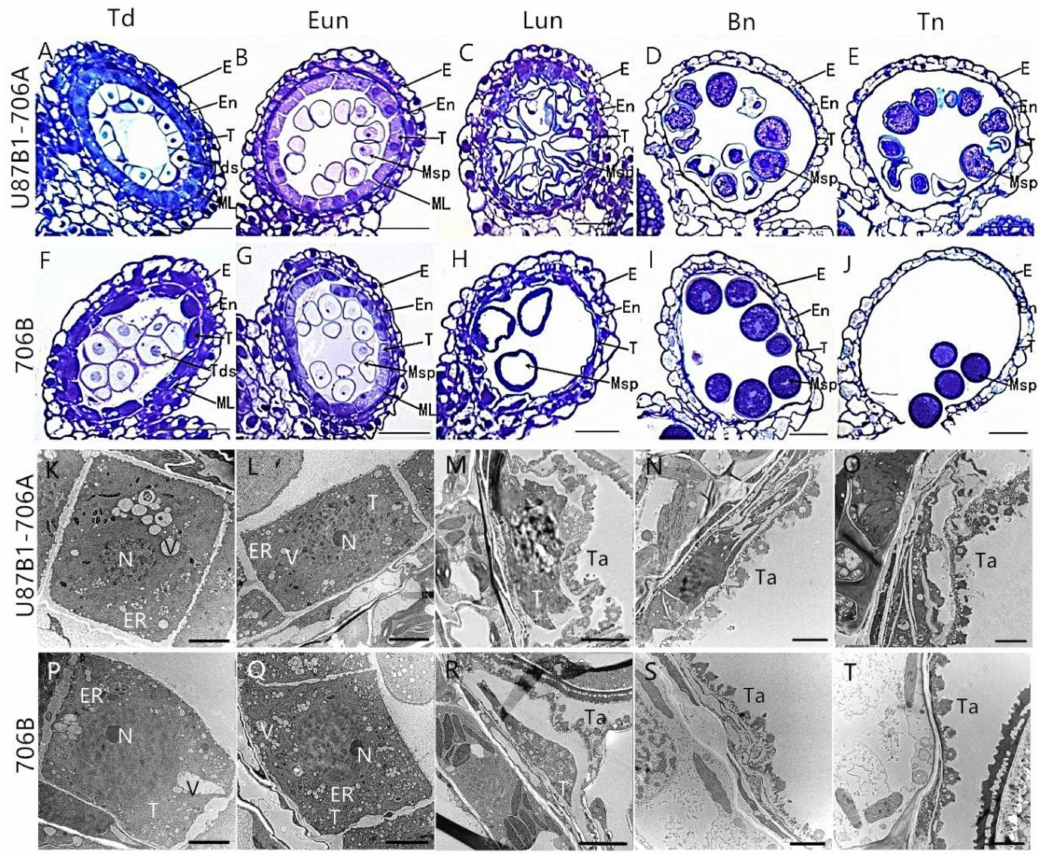
Figure 3. Comparisons of the anther tapetum ( A – J ) and ultrastructure ( K – T ) in U87B1-706A ( A – E , K – O ) and 706B ( F – J , P – T ) during different developmental stages. ( A , F , K , P ) Td, tetrad stage; ( B , G , L , Q ) Eun, early uninucleate stage; ( C , H , M , R ) Lun, late uninucleate stage; ( D , I , N , S ) Bn, binucleate stage; and ( E , J , O , T ) Tn, trinucleate stage. E, epidermis; En, endothecium; ER, endoplasmic reticulum; ML, middle layer; Msp, microspores; N, nucleus; T, tapetum; Ta: tapetosome; Tds, tetrads; V: vacuole. Scale bars are 50 µ m in ( A – J ) and 2 µ m in ( K – T